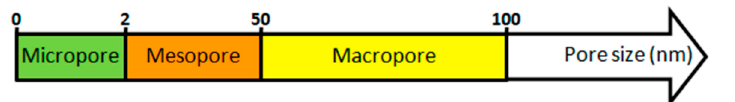
Figure 1. Classification of porosity based on pore diameter according to the International Union of Pure and Applied Chemistry (IUPAC).